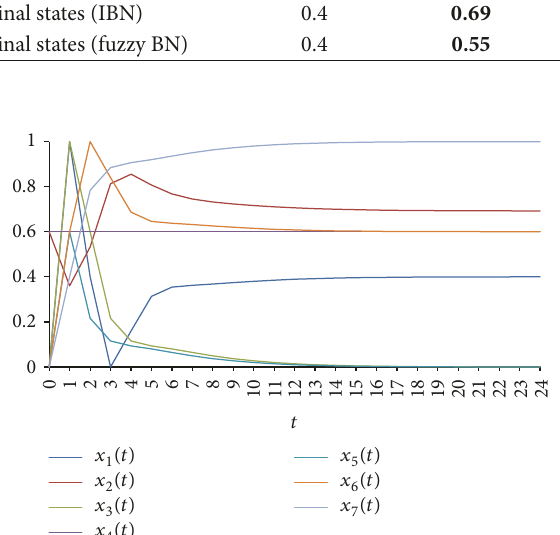
Figure 6: Dynamics of the fuzzy BN model for WNT5A gene reg- ulation with initial state conditions 𝑋(0) = [0; 0.6; 0; 0.6; 0;0; 0] and product operator used as 𝑡 -norm. The fuzzy BN model reaches the point attractor in 22nd iteration 𝑋(22) = [0.4; 0.55; 0; 0.6; 0; 0.6; 1]